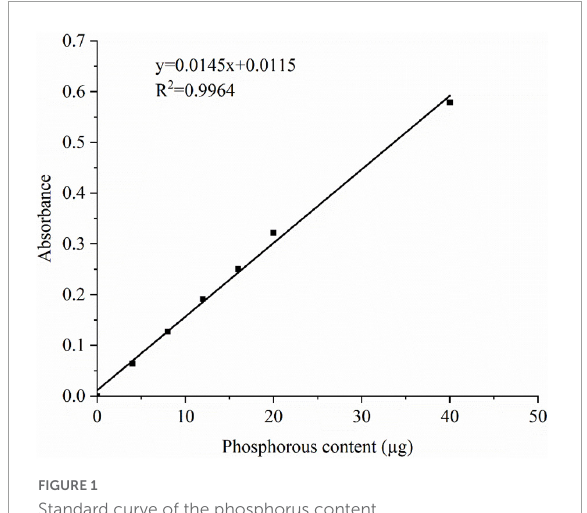
FIGURE1 Standard curve of the phosphorus content.